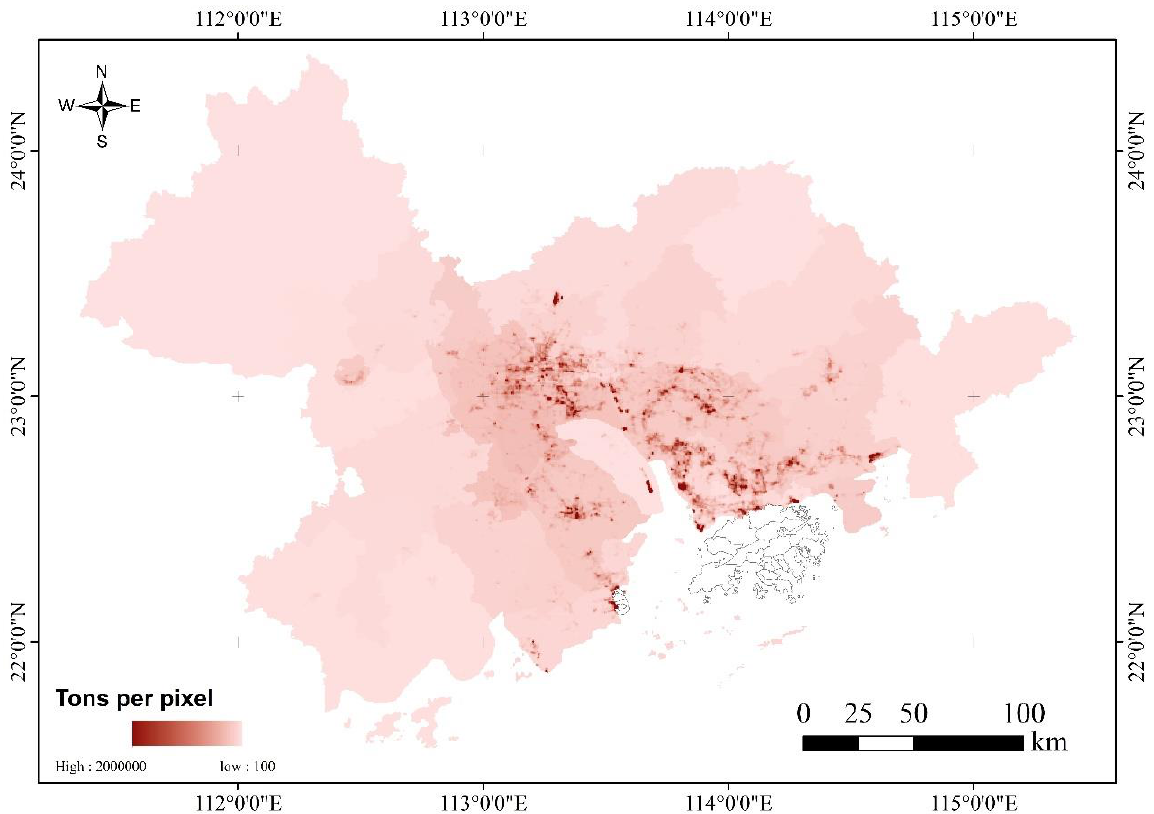
Figure 4. Forecast of per-pixel CO 2 emissions in the Pearl River Delta in 2017.